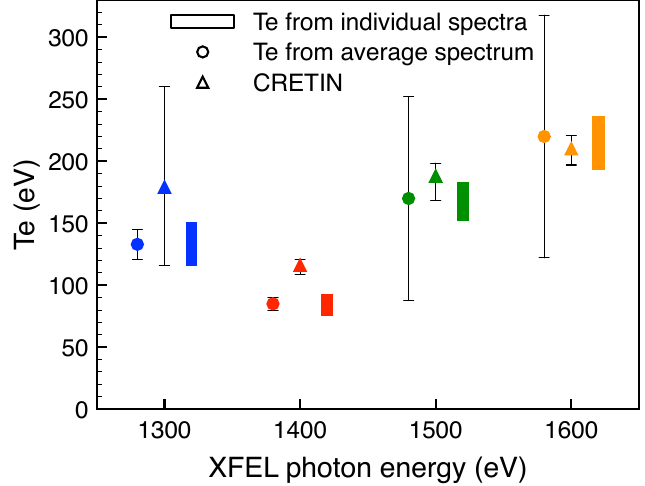
Figure 7. Comparison between the peak temperature of the plasma predicted by Cretin (triangles) and the results obtained from the experimental spectra for the different XFEL photon energies of consideration. The error bars in the Cretin results correspond to the variation of the peak temperature of the plasma when the intensity of the laser is varied by ∼± 15% as in the experiment. The circles correspond to the temperatures obtained from fitting the shot-averaged spectra, whereas the colored rectangles represent the range of temperatures obtained from individual shots by comparing their absolute spectral bound-free intensity with that of the average spectrum (shown in Figure 6), as given by I ∝ e ( − E / kT )